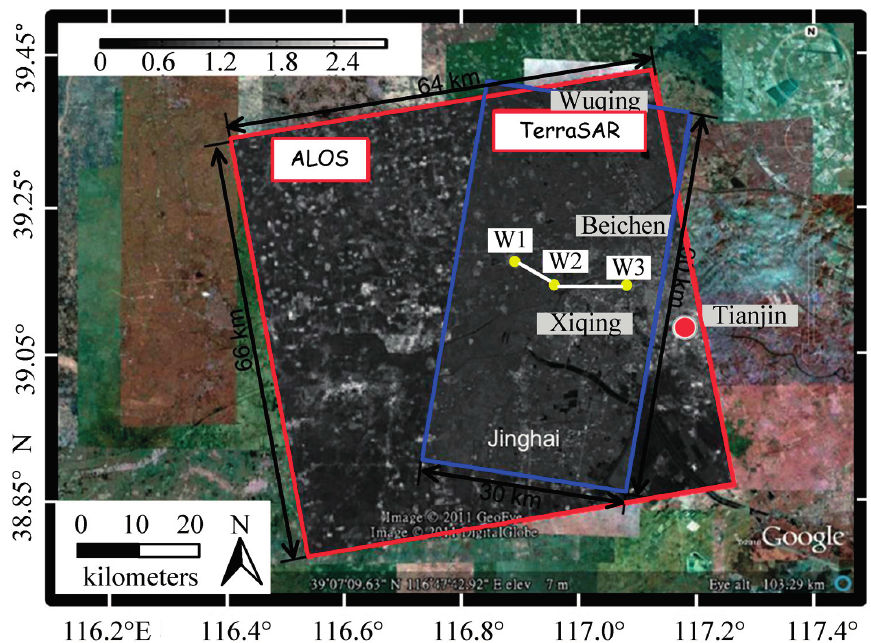
Figure 2. Spatial coverage of L- (red) and X-band (blue). The geological profile is marked with white line and three drilling locations are marked as W1, W2 and W3. Color scale represents SAR